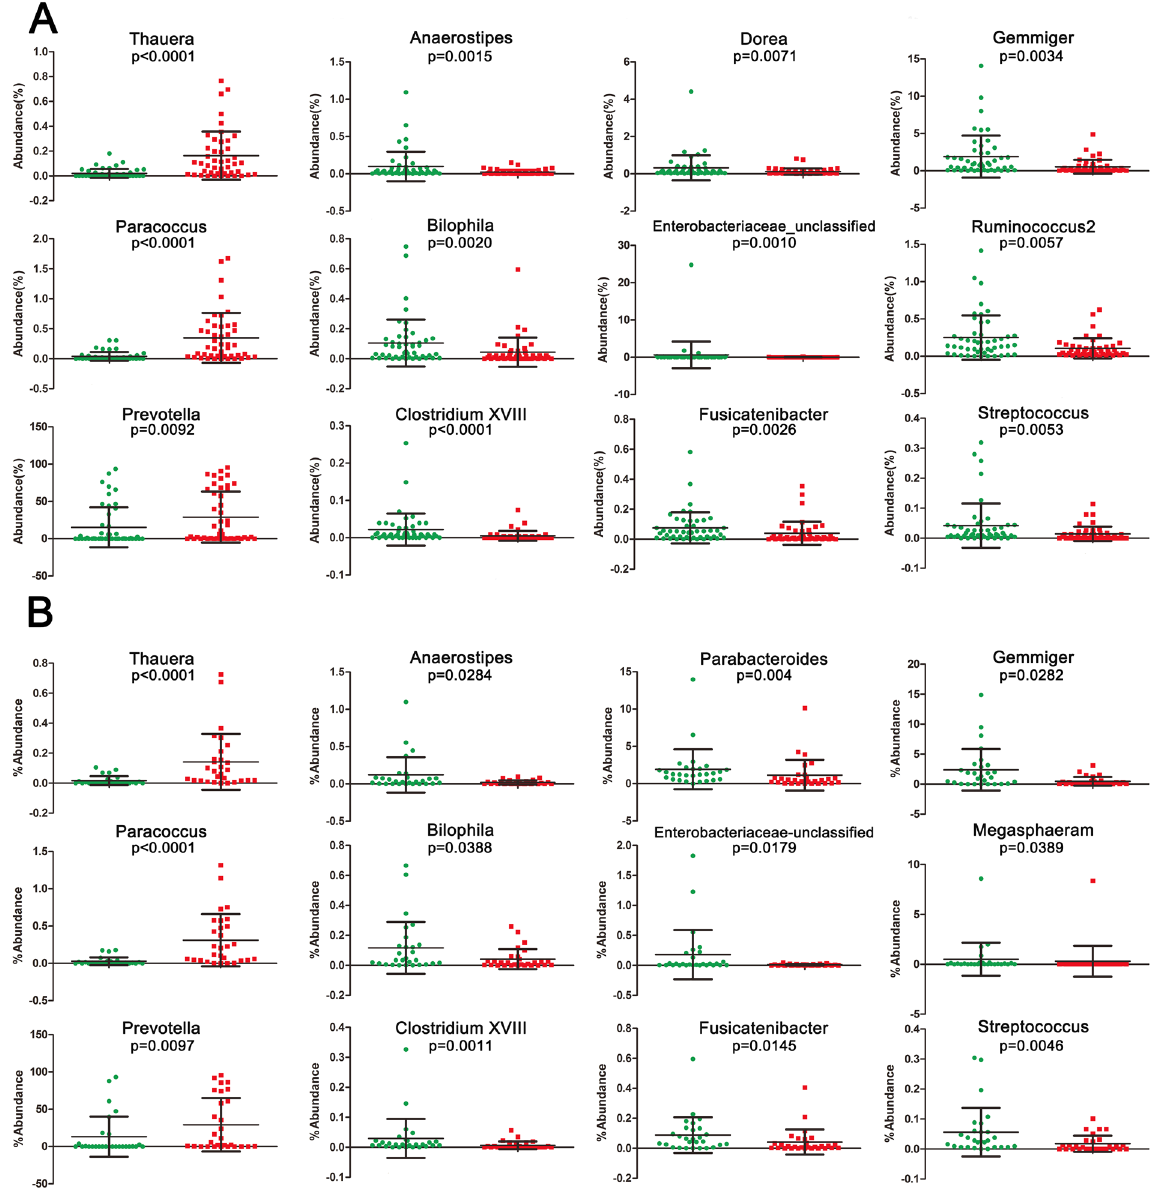
Figure 5. Scatterplots of bacterial taxa indicative of SUDs. HC samples are shown as green dots and samples from SUDs are shown as red dots. p -values were calculated using the Mann-Whitney test ( A ) for 93 samples analysis, while ( B ) had 57 samples